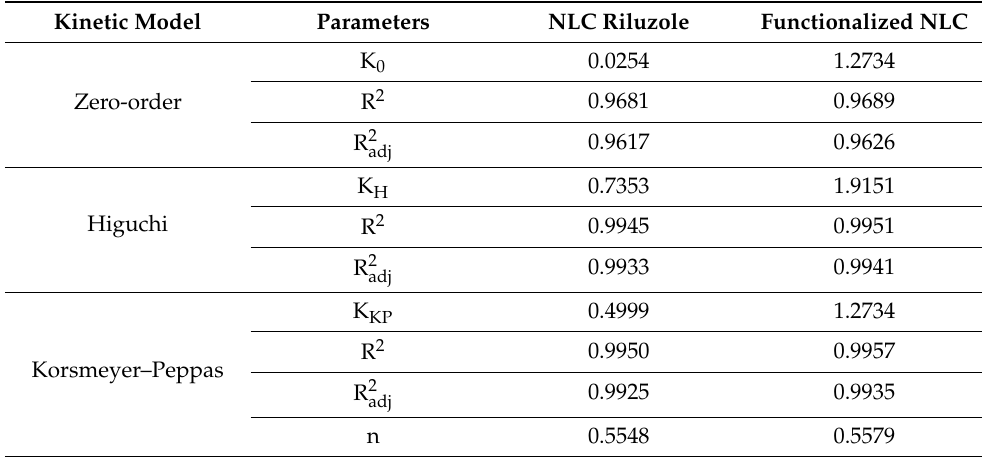
Table 3. Estimated kinetic parameters of the different mathematical models fitted to the riluzole release from NLC Riluzole and functionalized NLC.